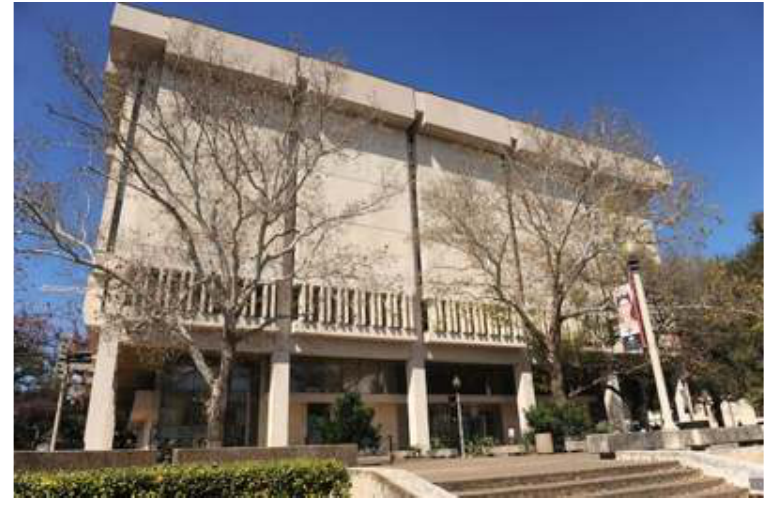
Figure 3: The Harry Ransom Center